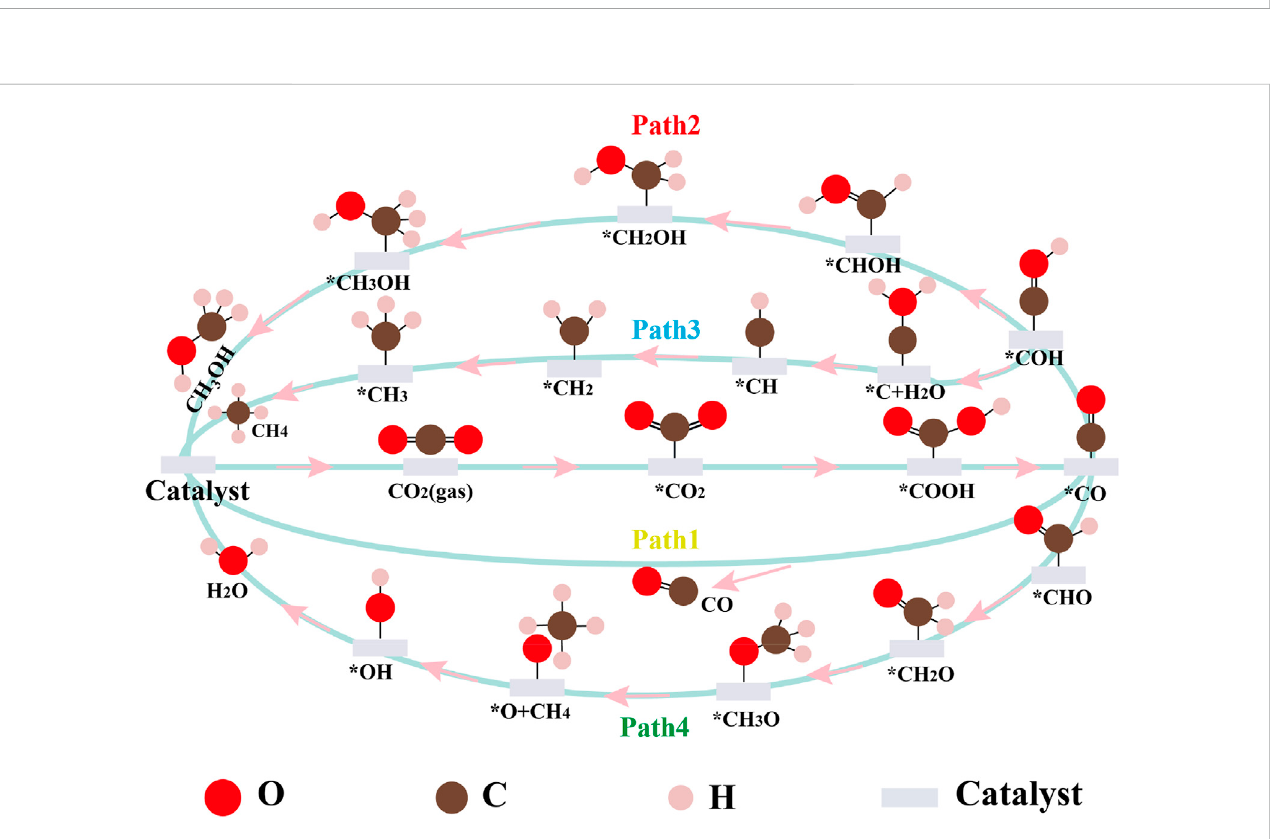
2 adsorptiononCu@CNTs,Cu 4 @CNTs,